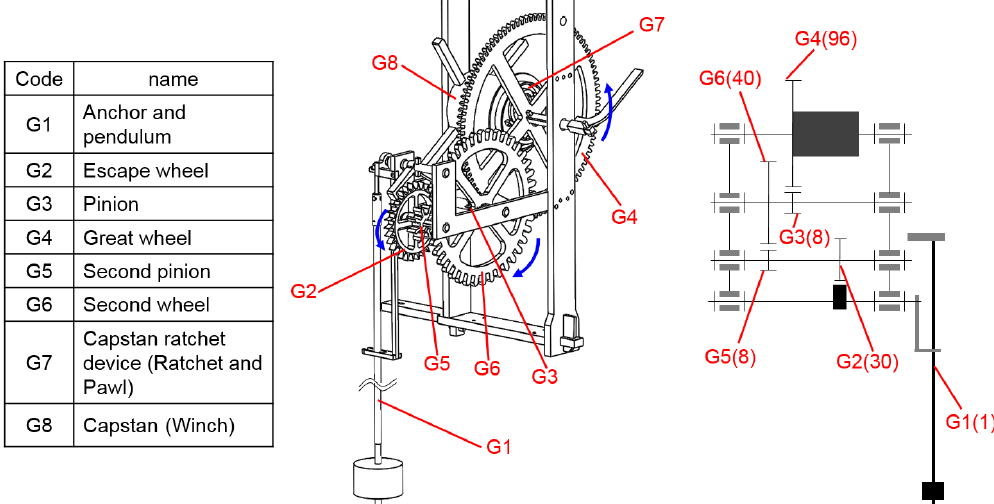
Figure 5. Going train structure of the Marston Magna clock (N3).